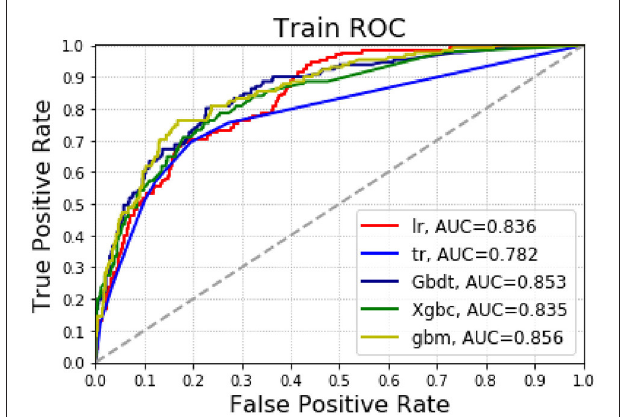
FIGURE 3 | AUC for predicting pulmonary complications using various machine learning algorithms in the training group.